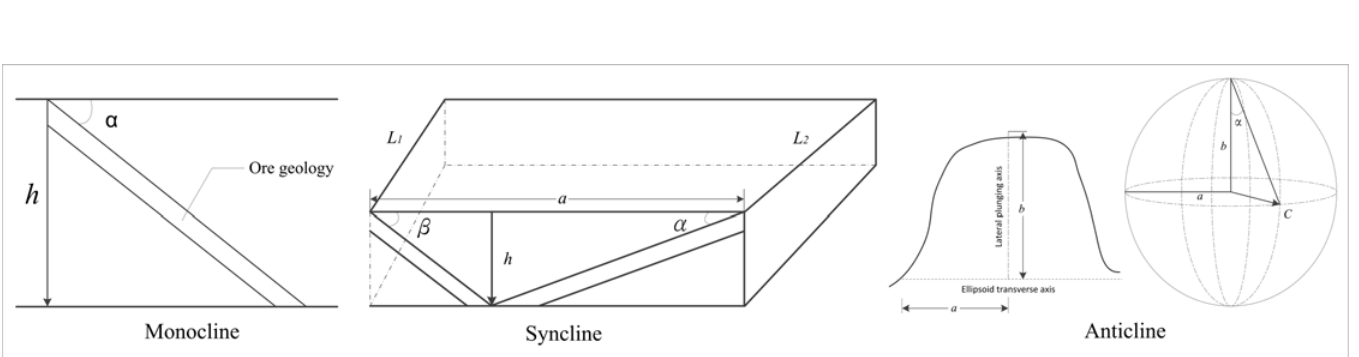
Fig 15. Graphical representation of the volume calculating